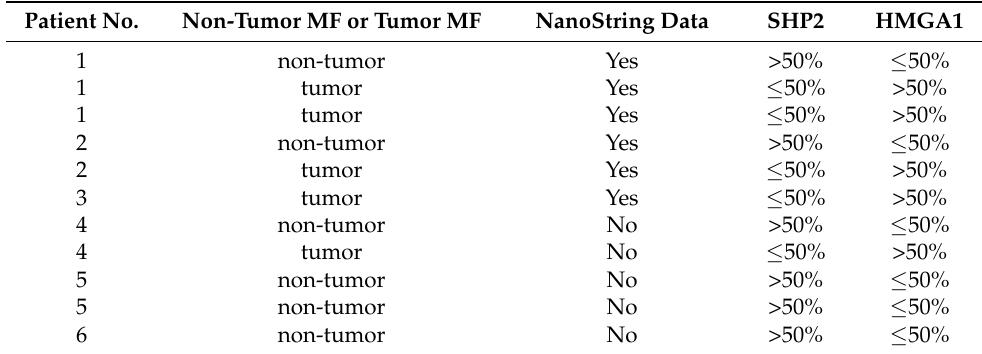
Table 5. Immunohistochemical analysis of MF patients showed SHP2 protein expression downregu- lated in tumor MF cases and HMGA1 protein expression upregulated in tumor MF